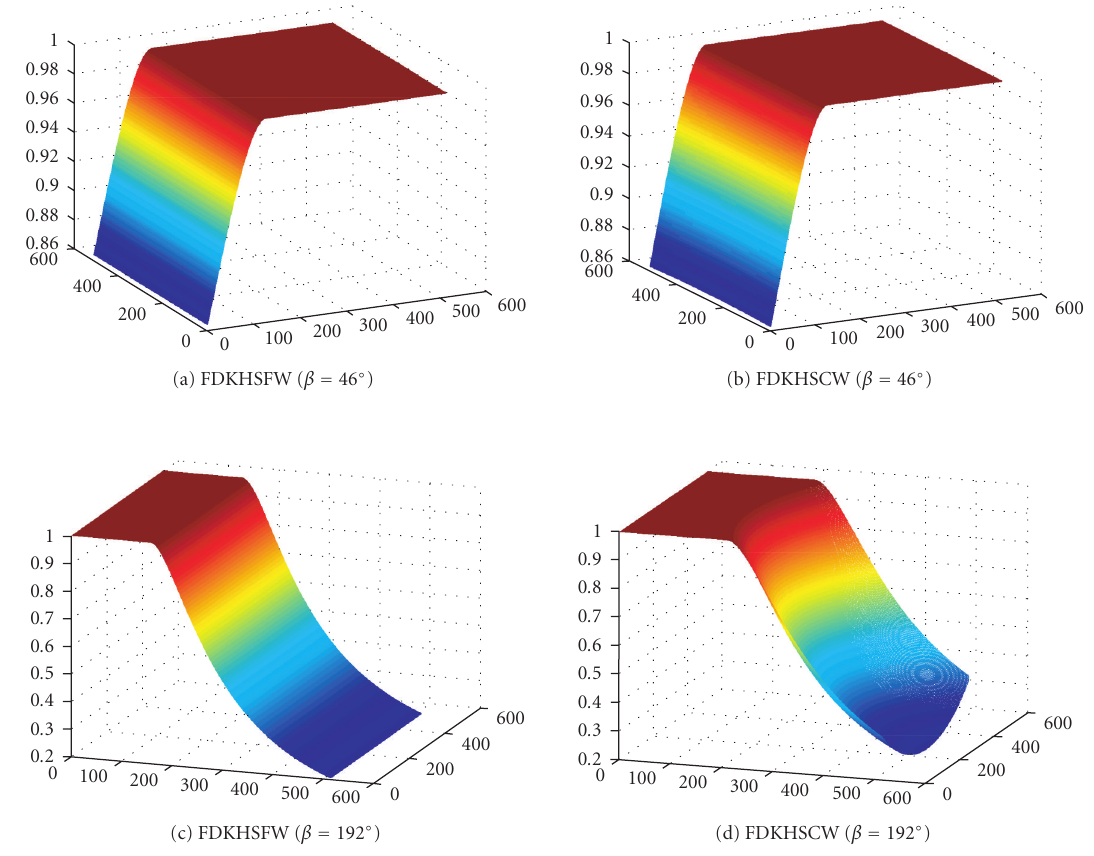
Figure 3: Weighting coe ffi cients comparison between FDKHSFW and FDKHSCW when β = 46 ◦ and when β = 192 ◦ as shown in (a), (b) and (c), (d),